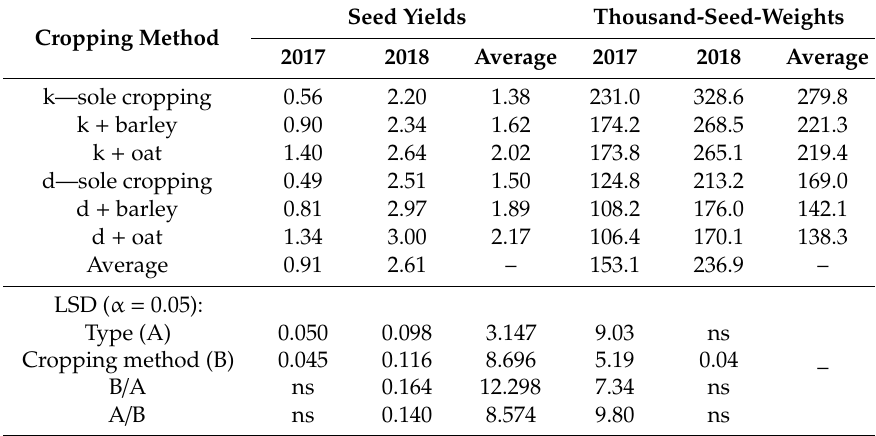
Table 1. Total seed yields of chickpeas and supporting plant (t · ha − 1 ) and 1000 seed weights (g), depending on cropping method and type (k—kabuli; d—desi; ns—not significant at Tukey’s test P ≤ 0.05). Seed Yields